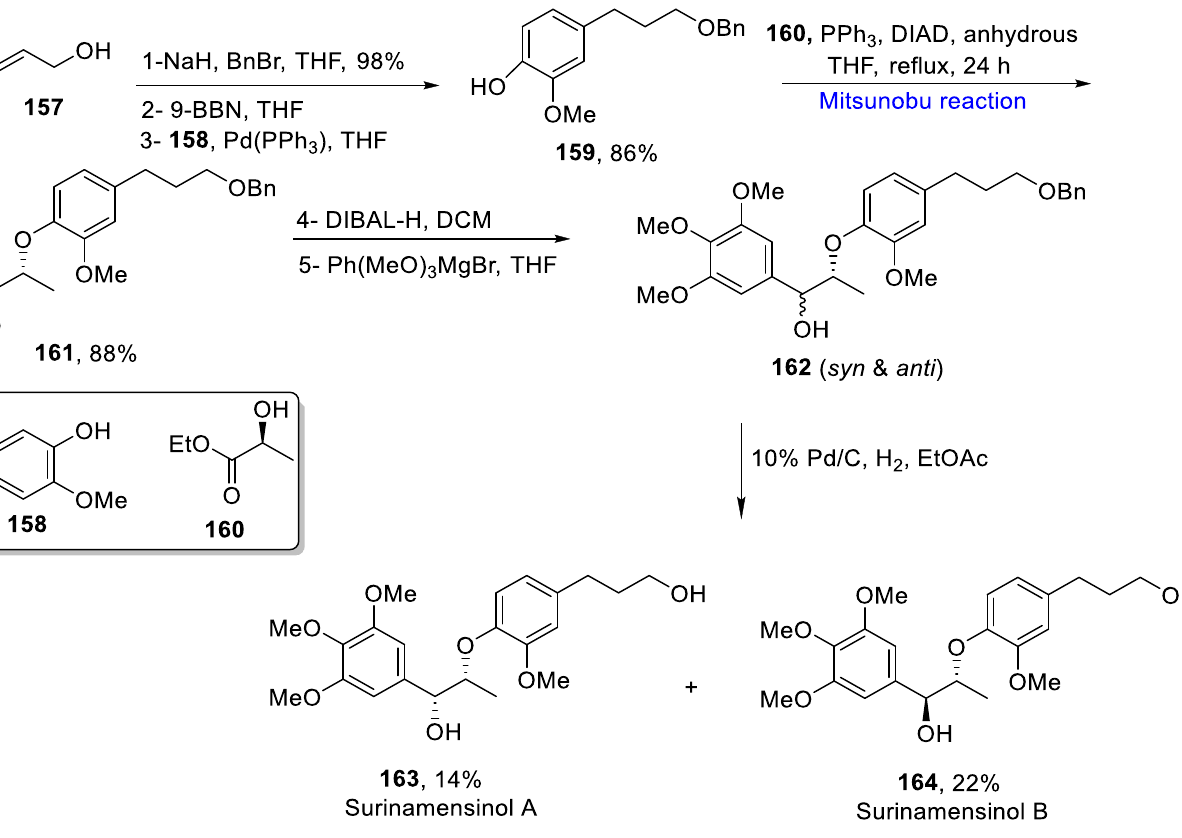
Scheme 21. Total synthesis of surinamensinols A 163 and B 164